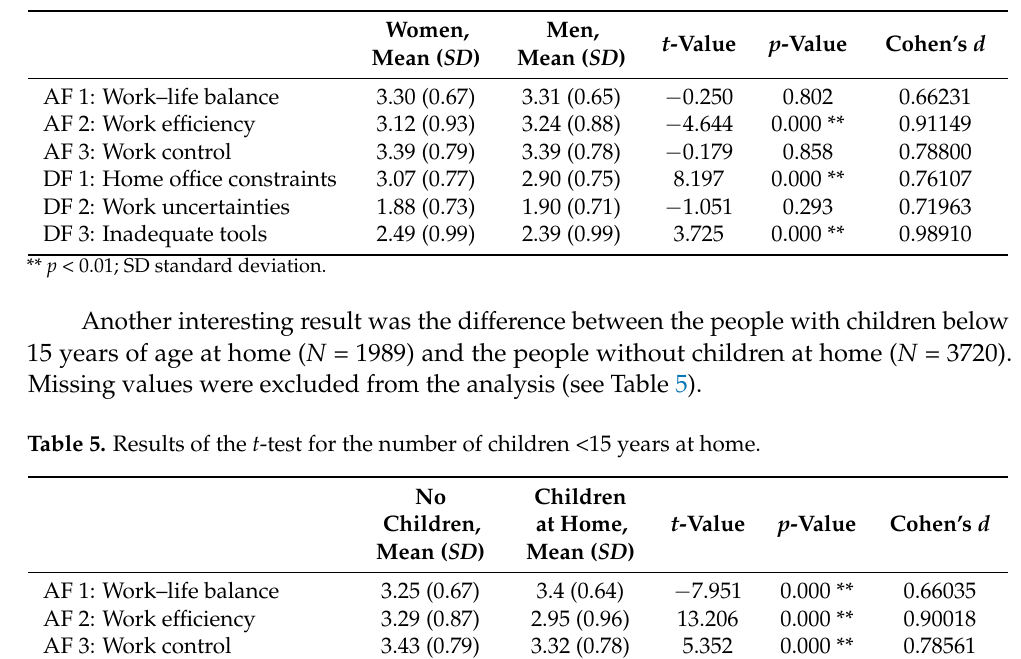
Table 4. Mean values, standard deviations and t -test results for gender.